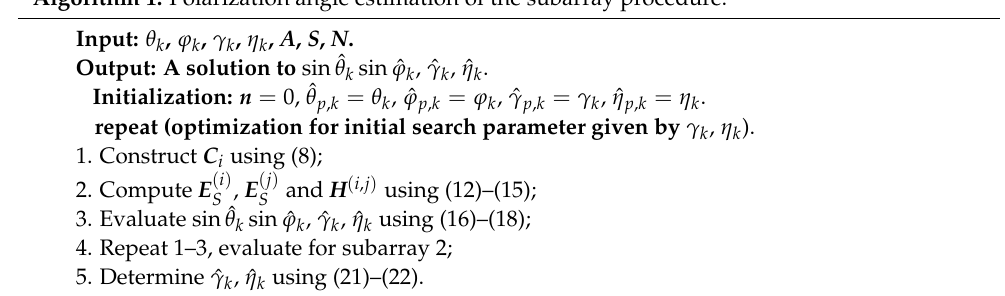
Algorithm 1: Polarization angle estimation of the subarray